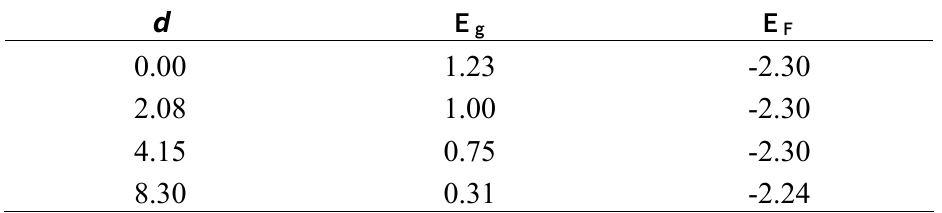
) and Fermi level * (E g